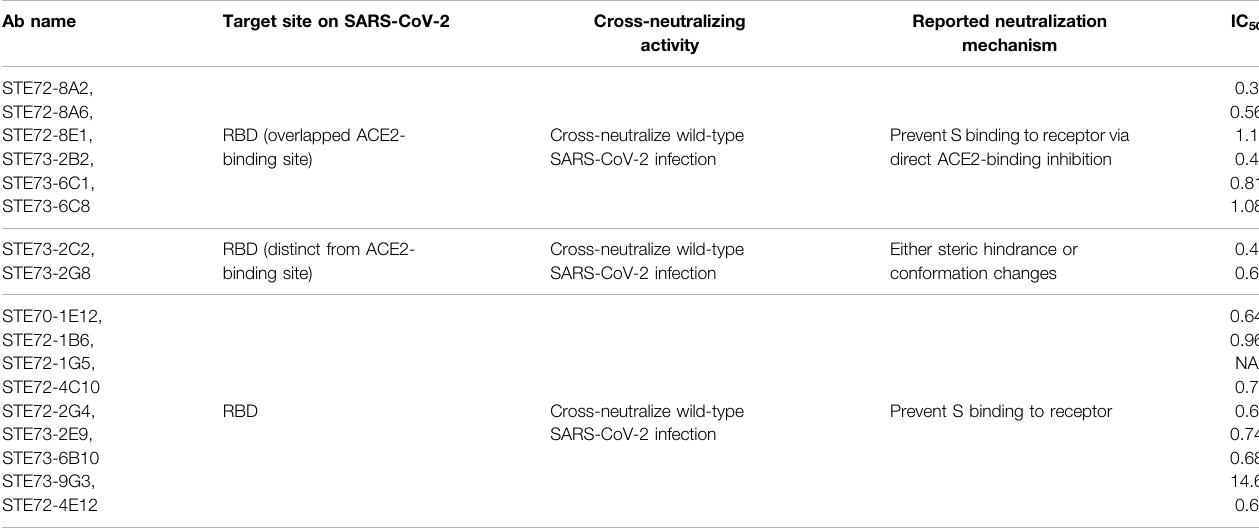
TABLE 2 | Reported healthy people-speci fi c NmAbs with neutralizing activity against